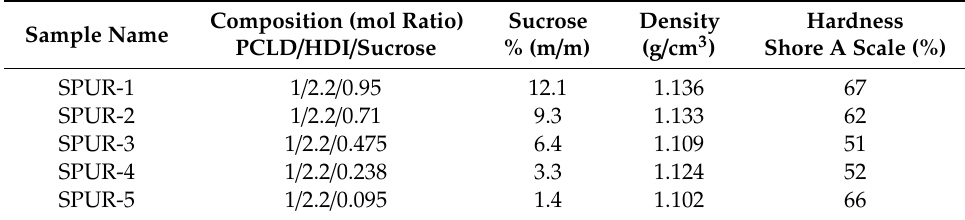
Table 1. Sample name, composition, density and Shore A hardness of sucrose containing PUR polymers (SPUR